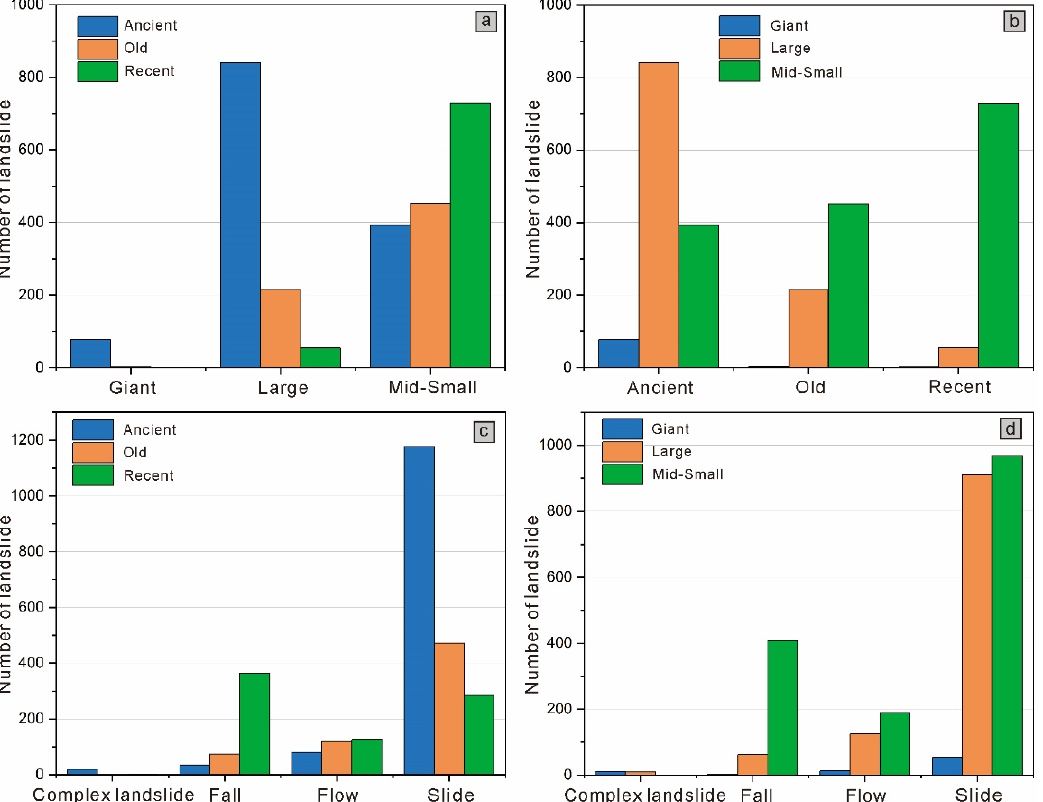
Figure 11. ( a ) relationship between landslide area and age, ( b ) relationship between landslide age and landslide area, ( c ) relationship between landslide type and landslide age, ( d ) relationship between landslide type and landslide area.